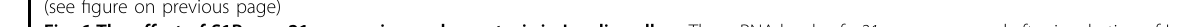
Fig. 6 The effect of S1P on p21 expression and apoptosis in Leydig cells. a The mRNA levels of p21 were measured after incubation of Leydig cells with different concentrations of S1P (0, 10, 30, 50 μ M) for 24 h. ( n = 3 independent experiments). b The mRNA levels of p21 were measured after incubation of Leydig cells with 30 μ M S1P for 0, 3, 6, 12 or 24 h. ( n = 3 independent experiments). c The mRNA levels of S1prs in Leydig cells. ( n = 3 independent experiments). d The mRNA levels of p21 , caspase-3 , Bax, and Bcl-2 were measured after incubation of Leydig cells with S1P (30 μ M) and/ or JTE-013 (7.5 μ M) for 6 h. ( n = 3 independent experiments). The protein levels of p21 ( e ) and cleaved caspase-3 ( f ) were measured after incubation of Leydig cells with S1P (30 μ M) and/or JTE-013 (7.5 μ M) for 6 h. ( n = 3 independent experiments). GAPDH was used as a loading control. g Immuno fl uorescence analysis of p21, TUNEL, and cleaved caspase-3 (green) in Leydig cells after incubation without or with S1P (30 μ M) for 6 h. ( n = 3 independent experiments). The nuclei were counterstained by DAPI (blue). Scale bars: 100 μ m. The percentage of Leydig cells with p21 ( h ),